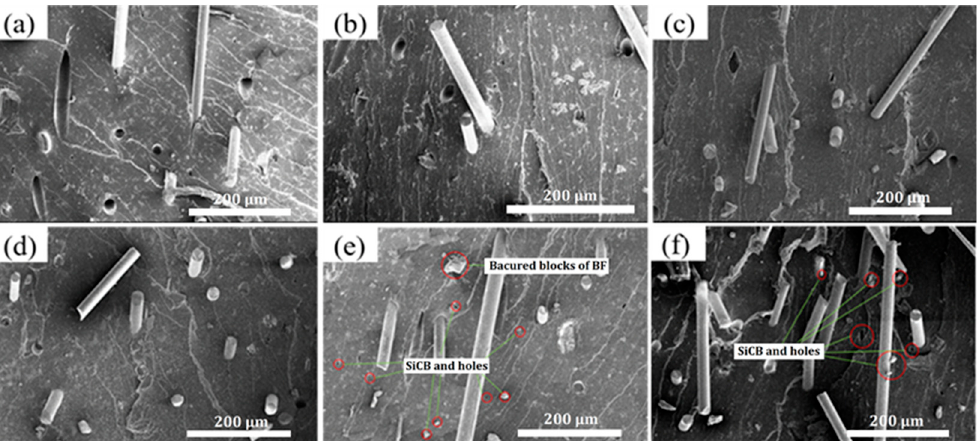
Figure 8. SEM images of rubber tensile fracture surface ( a ) MREs/BF ( b ) MREs/BF H ( c ) MREs/PDA- BF ( d ) MREs/PDA-BF H ( e ) MREs/PDA-BF-SiCB ( f ) MREs/PDA-BF H -SiCB.